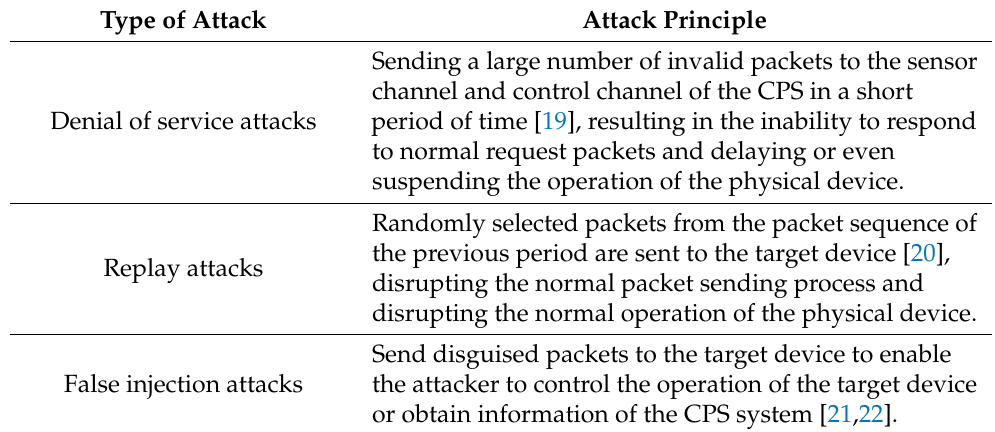
Table 2. Types of network attacks and attack